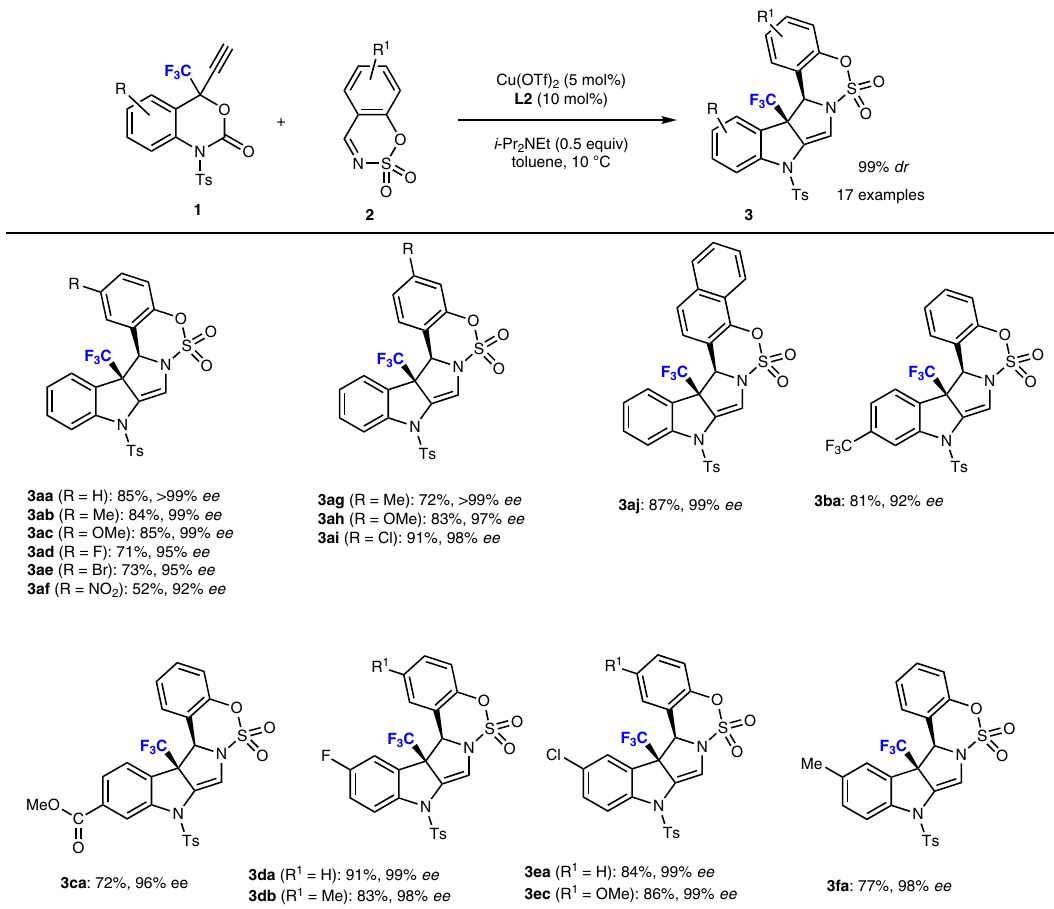
Fig. 3 Substrate scope for the mode B annulation of 1 with 2. Reaction conditions: 1 (0.1 mmol), 2 (0.11 mmol), Cu(OTf) 2 (5 mol%), L2 (10 mol%), and i - Pr 2 NEt (0.05 mmol) in 1.0 mL of toluene. The yield values refer to the isolated yield. In all cases, a > 99:1 diastereomeric product ( 3 ) ratio was obtained. The ee values were determined by chiral HPLC